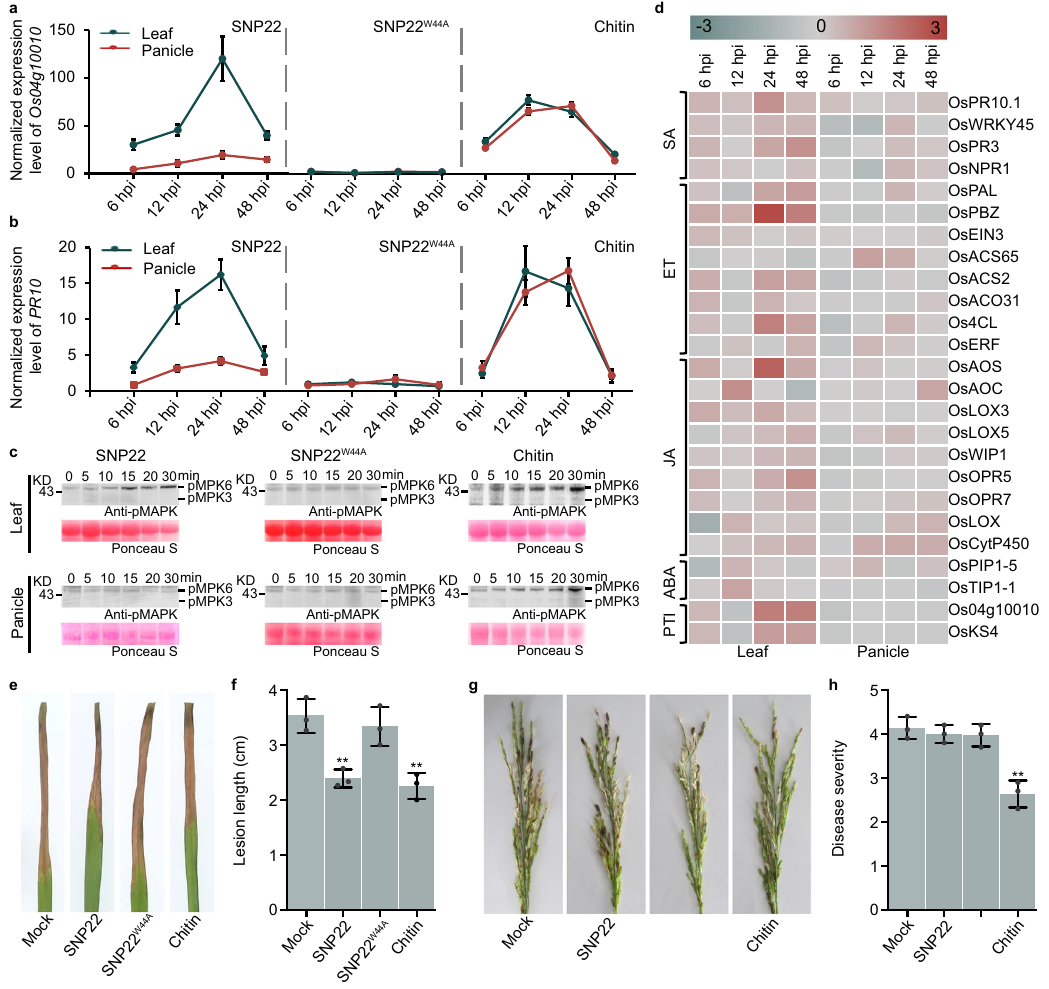
Fig. 7 Immune responses triggered by SNP22 in rice leaves and panicles. a – c Rice leaves and panicles were treated with either 1 μ M SNP22 peptide, SNP22 W44A peptide, or chitin (hexa- N -acetylchitohexaose). a , b Relative induction of defense-related gene expression in rice leaves and panicles triggered by the indicated elicitors. Defense-related gene expression was normalized to that of mock at each time points after treatment. Rice actin served as an internal reference. Values represent the means ± SEM of three biological replicates. c MAPK activation in rice leaves and panicles triggered by elicitors. The phosphorylation level of MAPK detected by immunoblot with anti-phospho-p44/42 MAPK (Erk1/2) antibody. d Transcriptome analysis. The relative gene expression was normalized to those of mock treatment at each time point post-treatment. Heatmap was shown based on lg values of the fold change. Cyan color, downregulation; red color, upregulation. e – h Disease resistance to X. oryzae pv. oryzae in rice leaves and to B. glumae in rice panicles triggered by the indicated elicitors. Rice leaves and panicles were pretreated with either 1 μ M SNP22, SNP22 W44A , or chitin 24 h before pathogen inoculation. Symptoms were assessed at 7 dpi. Three independent experiments were performed, and ten leaves or ten panicles were used for each experiment. e Representative photographs of symptoms on rice leaves caused by X. oryzae pv. oryzae . f Lesion lengths. Values represent the means ± SD of three independent experiments, with ten leaves in each experiment (** P < 0.01 compared with Mock, two-sided Dunnett ’ s test). g Representative photographs of disease symptoms on rice panicles caused by B. glumae . h Disease severity in rice panicles, evaluated as described in the “ Methods ” section. Values represent the means ± SD of three independent experiments, with 10 panicles per treatment in each experiment (** P < 0.01 compared with Mock, two-sided Dunnett ’ s